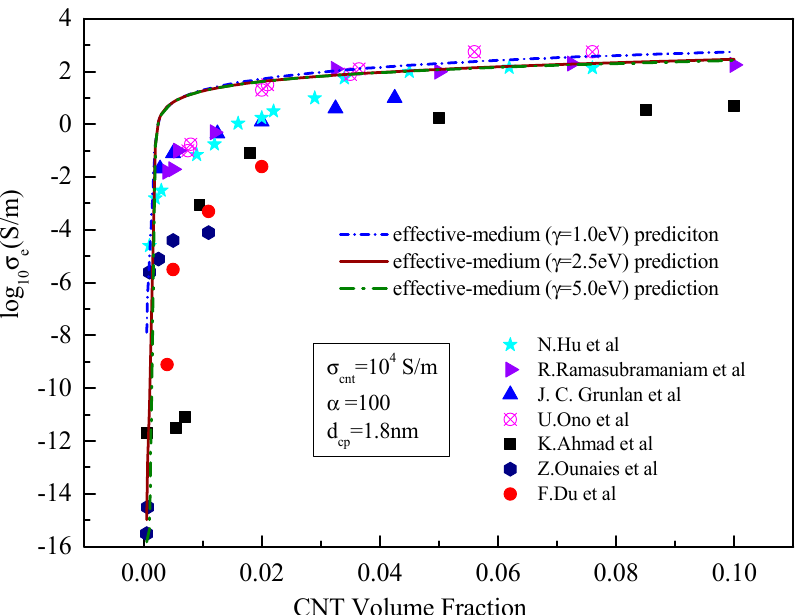
Figure 8. Comparison between the prediction results of the effective medium model and existing experimental data [21,23–28] with the variable barrier height.